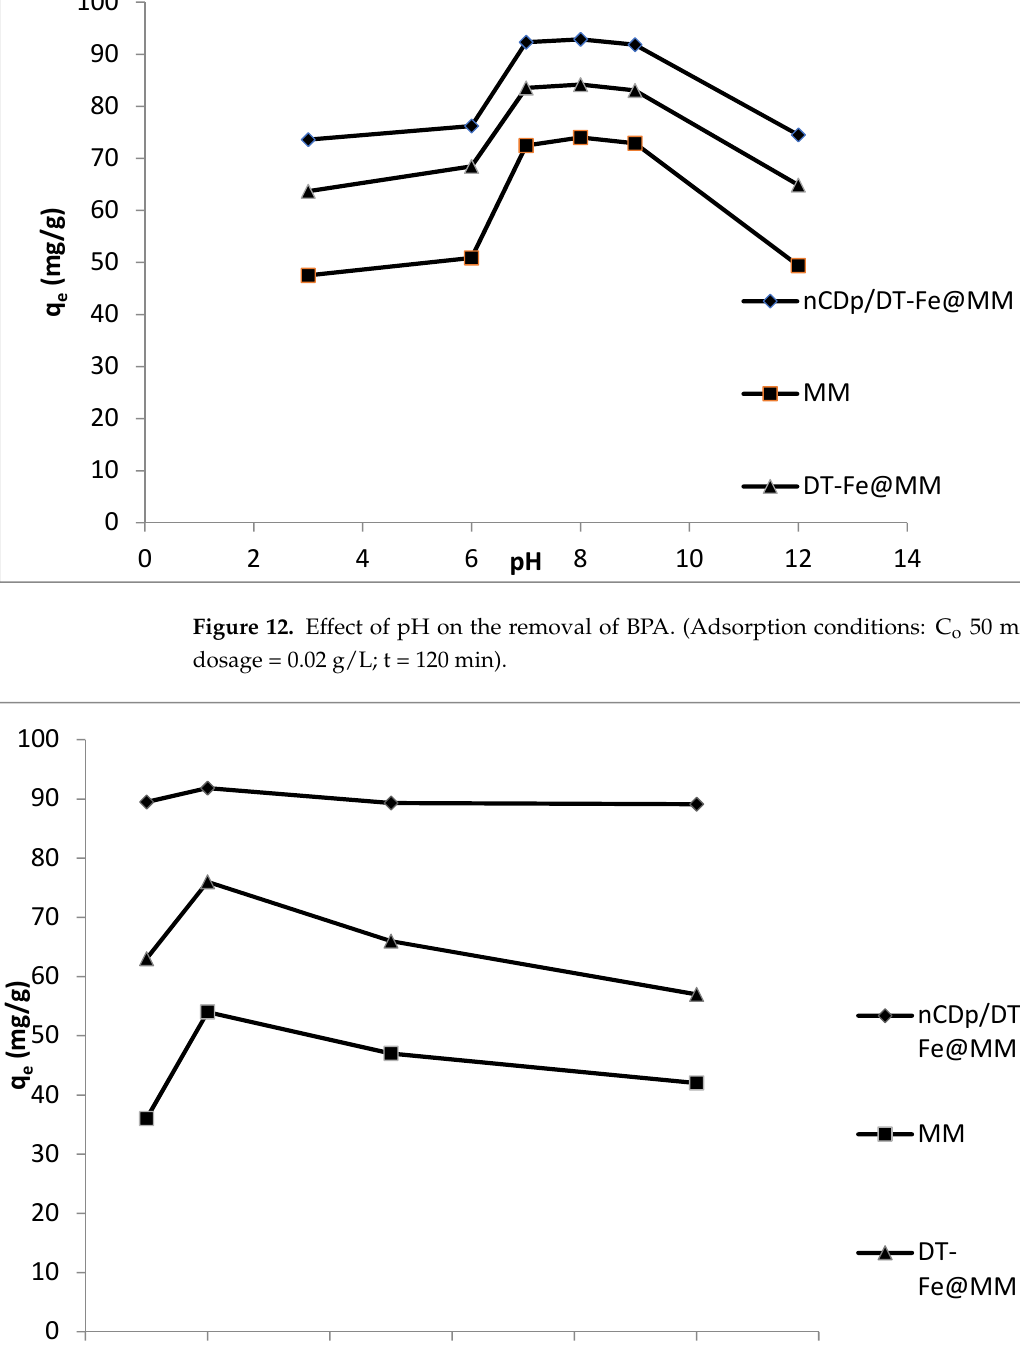
Figure 13. Effect of adsorbent particle size on the removal of BPA. (Adsorption conditions: C o 50 mg/L; T = 30 °C; dosage = 0.02 g/L; t = 120 min; pH = 8).